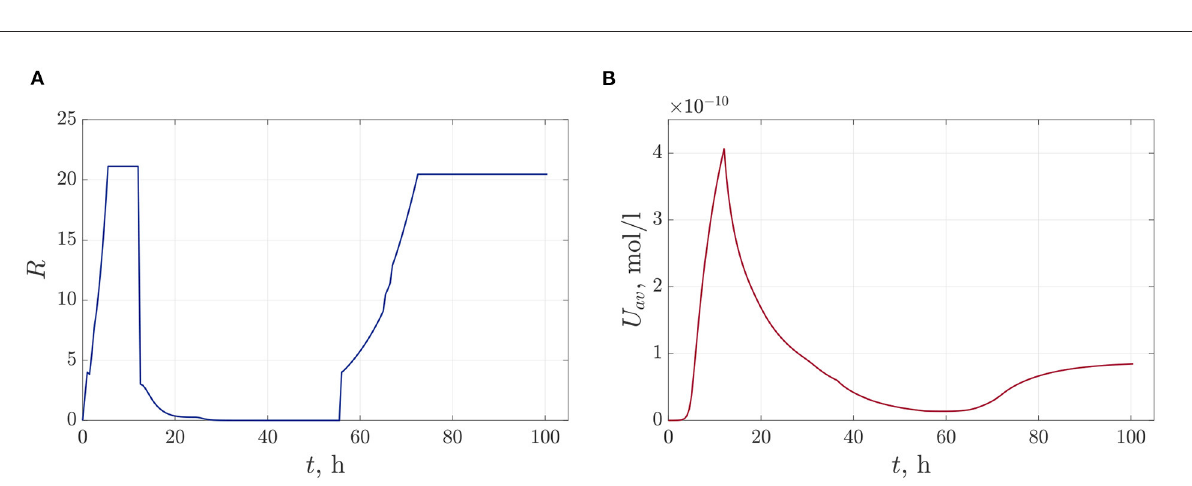
FIGURE11 The time dependence of the total linear size of bacterial colonies— (A) and the dynamics of the average value of the AHL concentration— (B) .